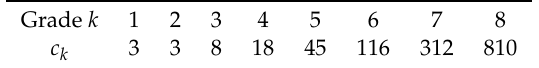
Table 1. Number of order conditions to be satisfied by a splitting method of the form Equation (5) at each order k . Grade k 1 2